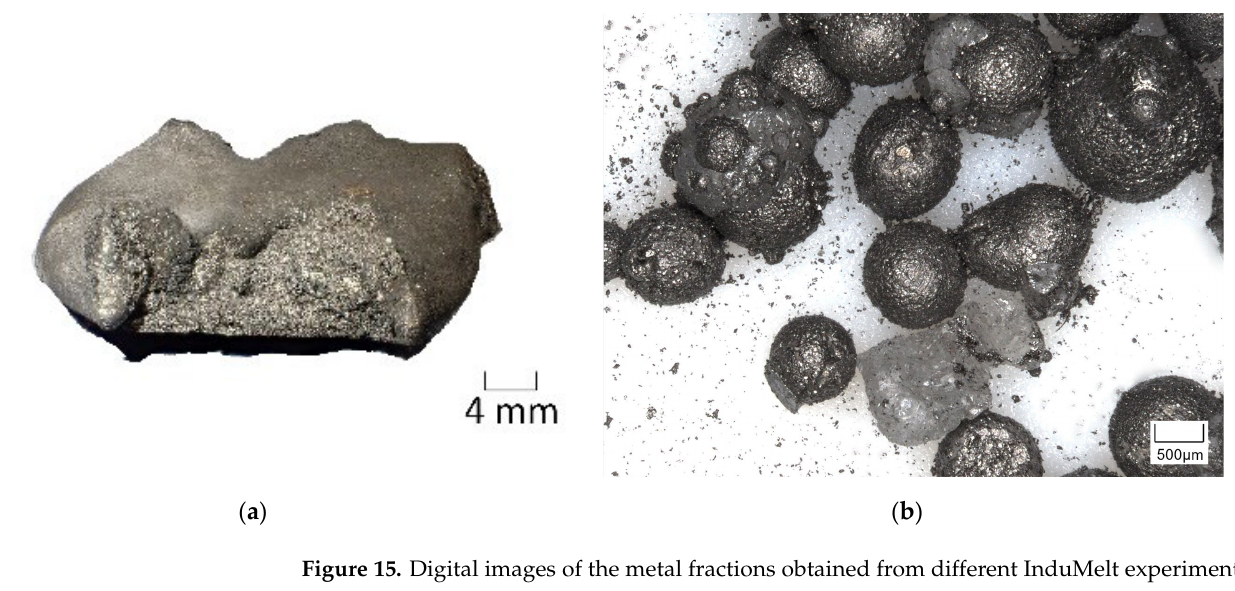
Figure 15. Digital images of the metal fractions obtained from different InduMelt experiments for comparison: ( a ) trial with NCA without impurities such as Cu and Al [38]; ( b ) trial with NCA_AM.